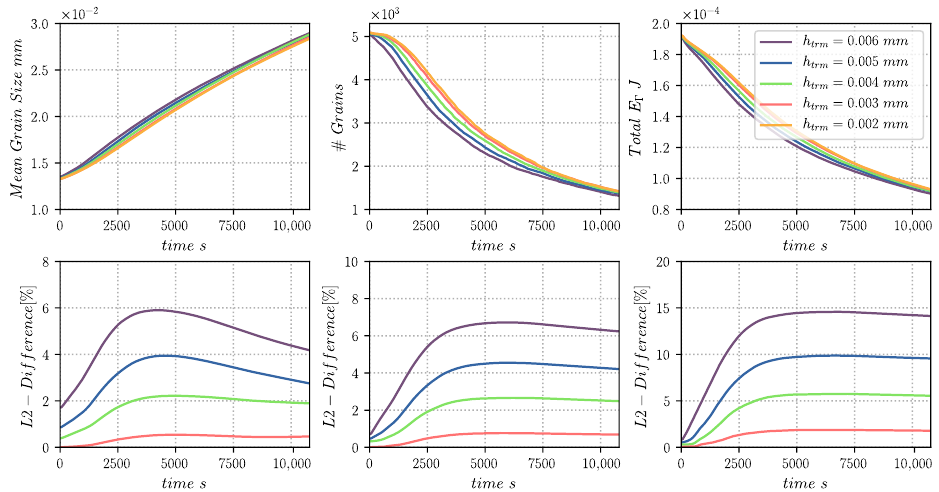
Figure A3. Sensitivity to the mesh size h trm for the 2D heterogeneous GG test case using the TRM model and dt = 50 s. The evolution of different parameters is given when using the RS function for the determination of the GB energy γ as a function of the disorientation angle θ : ( left ) grain Size, ( center ) number of grains, and ( right ) total GB energy. Each value ( top ) is compared to the evolution of the smallest h trm . L2-Difference values are given ( bottom